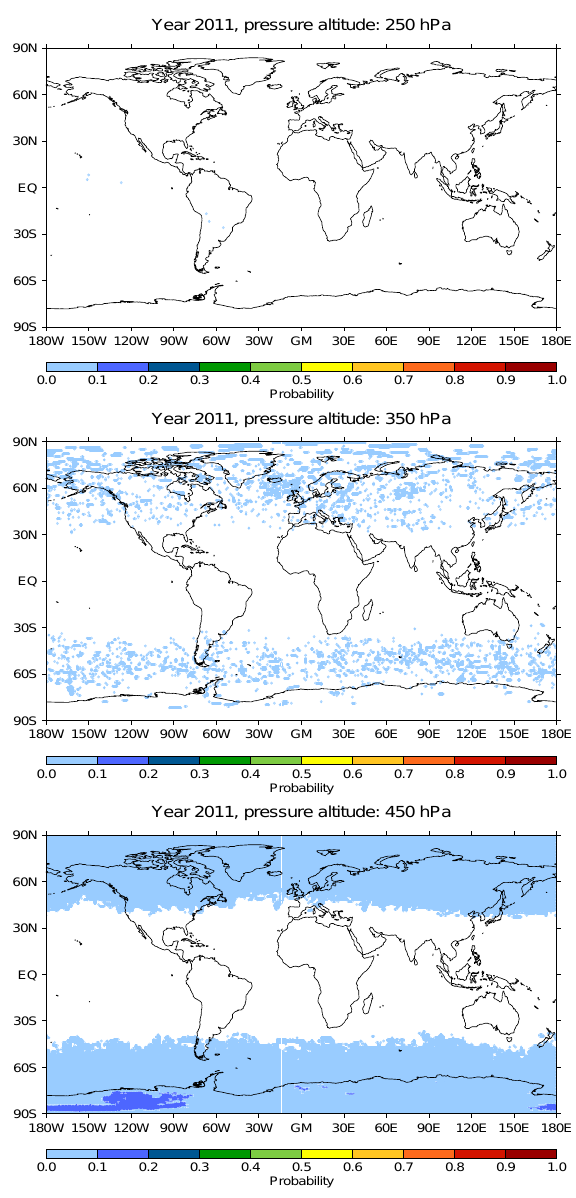
Fig. 7. Regions where aerodynamic and exhaust contrails can form simultaneously together with the respective probabilities are shown for the three pressure levels 250, 350, and 450 hPa (from top to bottom). Persistence, i.e. ice supersaturation, was not accounted for.